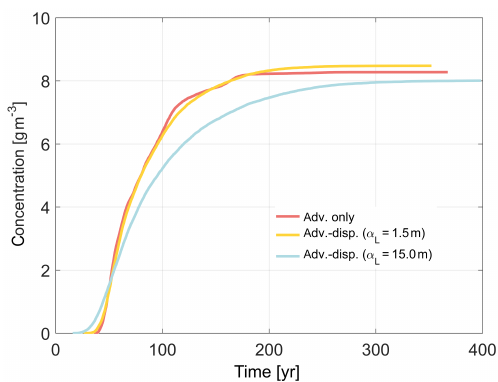
Figure B1. Breakthrough curve recorded at a well accounting for advection only (red curve), for advection and dispersion with a lon- gitudinal dispersivity of 1.5m (yellow curve), and for advection and dispersion with a longitudinal dispersivity of 15.0m (blue curve). Transverse horizontal and transverse vertical dispersivities are al- ways, respectively, 1 / 10 and 1 / 100 of the longitudinal